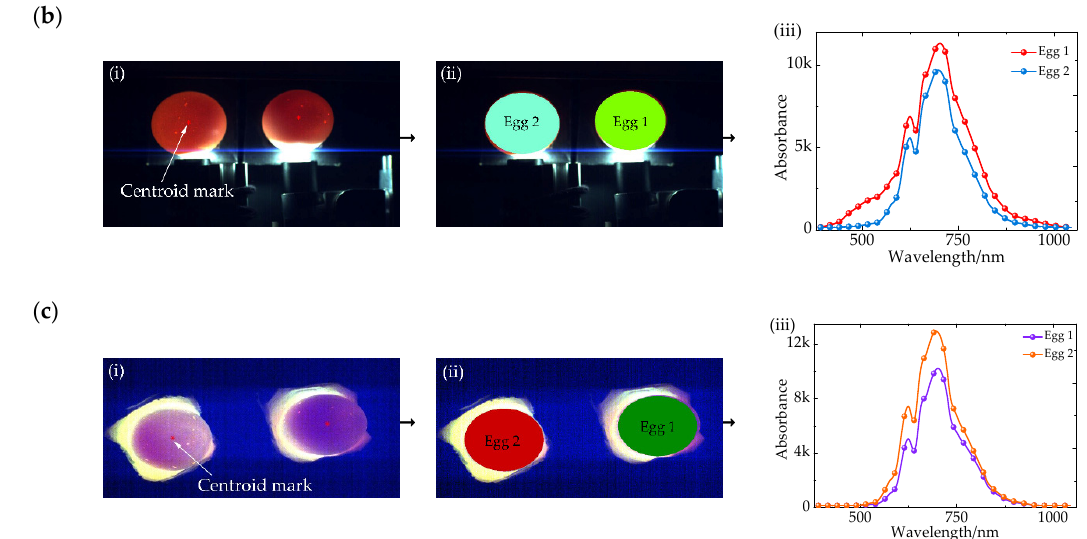
Figure 3. Region-of-interest (ROI) extraction processes. ( a ) Reflection; ( b ) Transmission; ( c ) Mixed hyperspectra; ( i ) Centroid mark; ( ii ) ROI; ( iii ) Original hyperspectral.